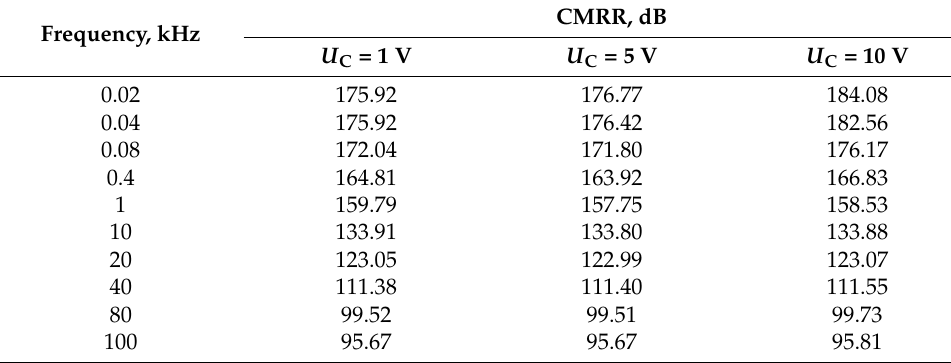
Table 2. CMRR values for the differential signal recovery.